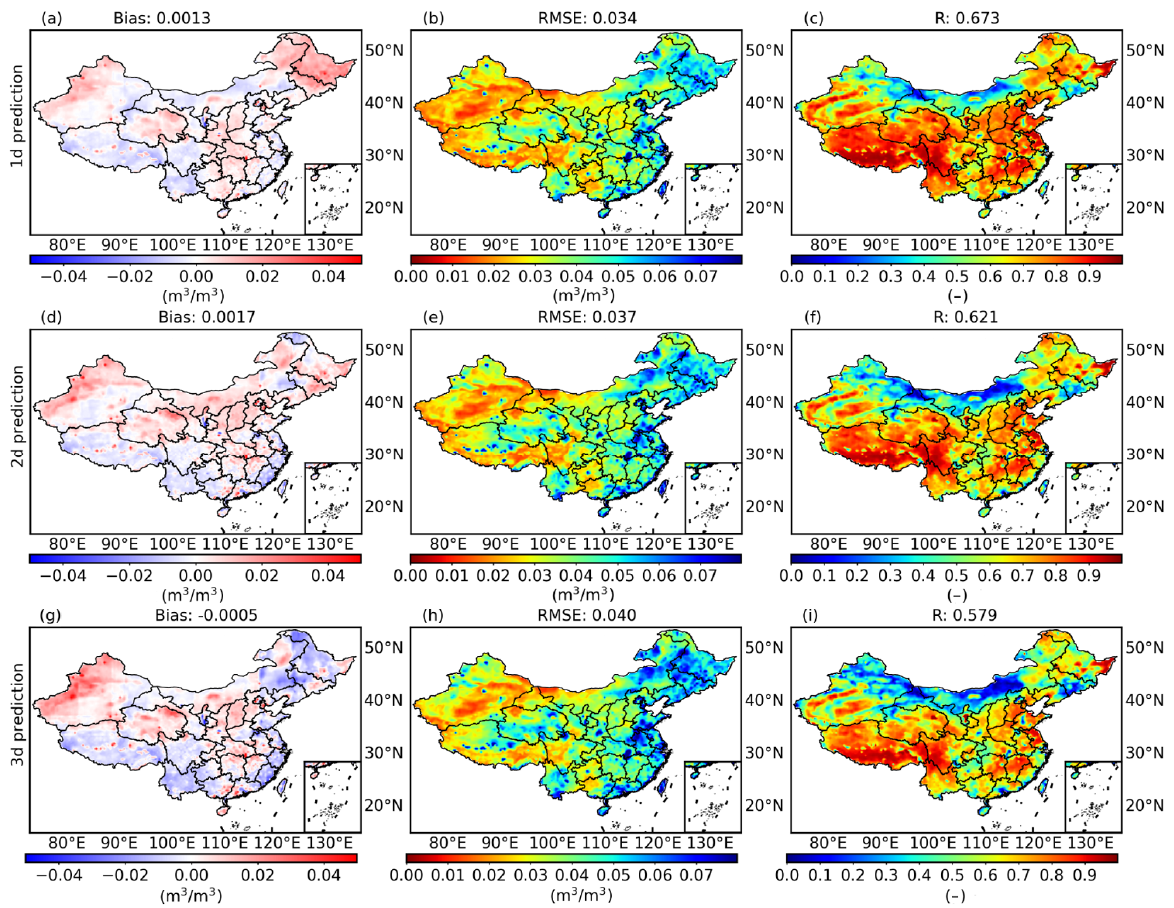
Figure 4. Performance of ConvGRU model with data integration (DI_ConvGRU) during the test period from 1 April 2017 to 31 March 2018 in China. Shown are the Bias ( a , d , g ) for 1-, 2-, and 3-day forecasts, respectively, RMSE ( b , e , h ) and R ( c , f , i